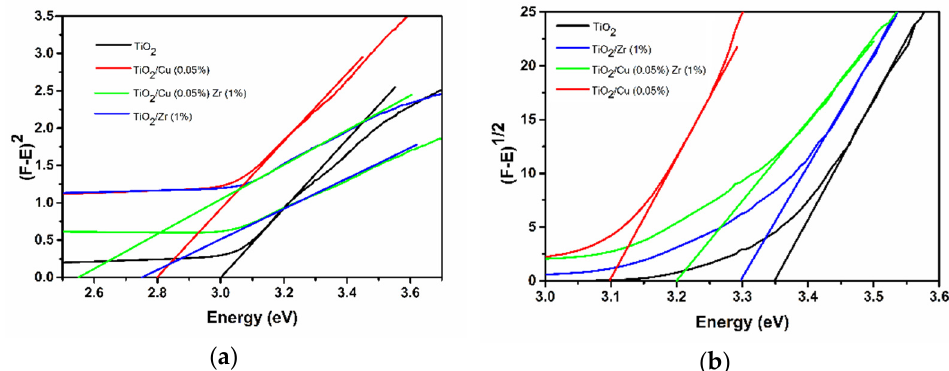
Figure 8. Extrapolation of the direct ( a ) and indirect ( b ) band gaps on the basis of [ α h υ ] n versus h υ dependence. Table 1. Values of the direct and indirect band gaps and 95% CI of the unmodified and Cu- or/and Zr-modified TiO 2 obtained by UV–Vis spectrophotometry and Kubelka–Munk theory.